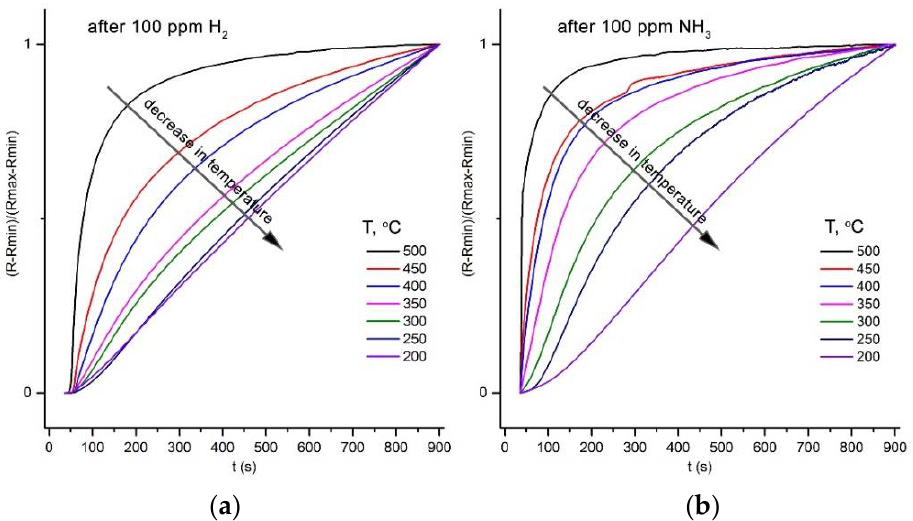
Figure 9. Temperature dependence of the rate of the resistance recovery in background gas with 0.0005% O 2 after 100 ppm H 2 ( a ) or 100 ppm NH 3 ( b ) is turned off.